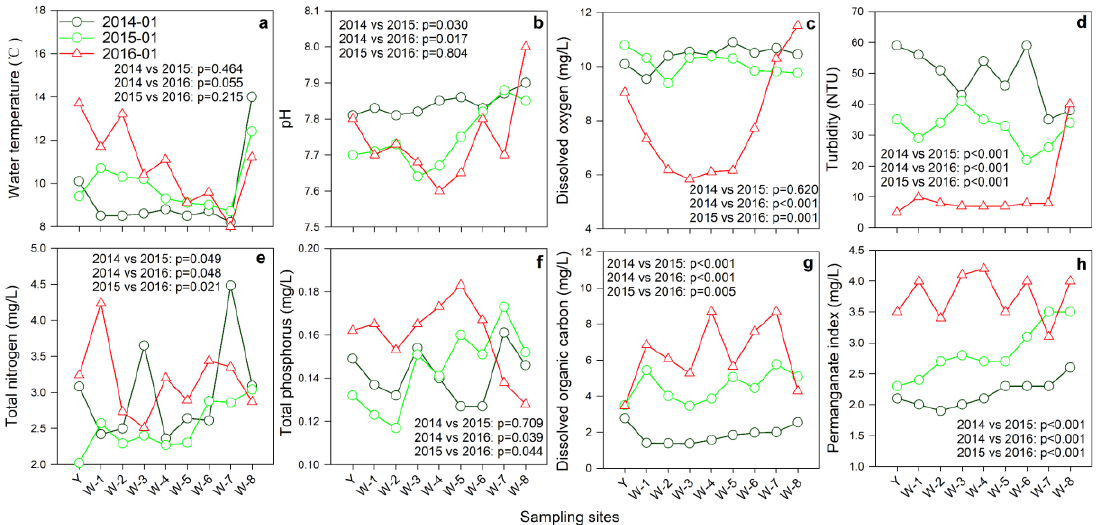
Figure 2. Spatio-temporal variations of physicochemical parameters along with the Wangyu River channel. ( a ) water temperature; ( b ) pH; ( c ) dissolved oxygen; ( d ) turbidity; ( e ) total nitrogen; ( f ) total phosphorus; ( g ) dissolved organic carbon; ( h ) permanganate index.